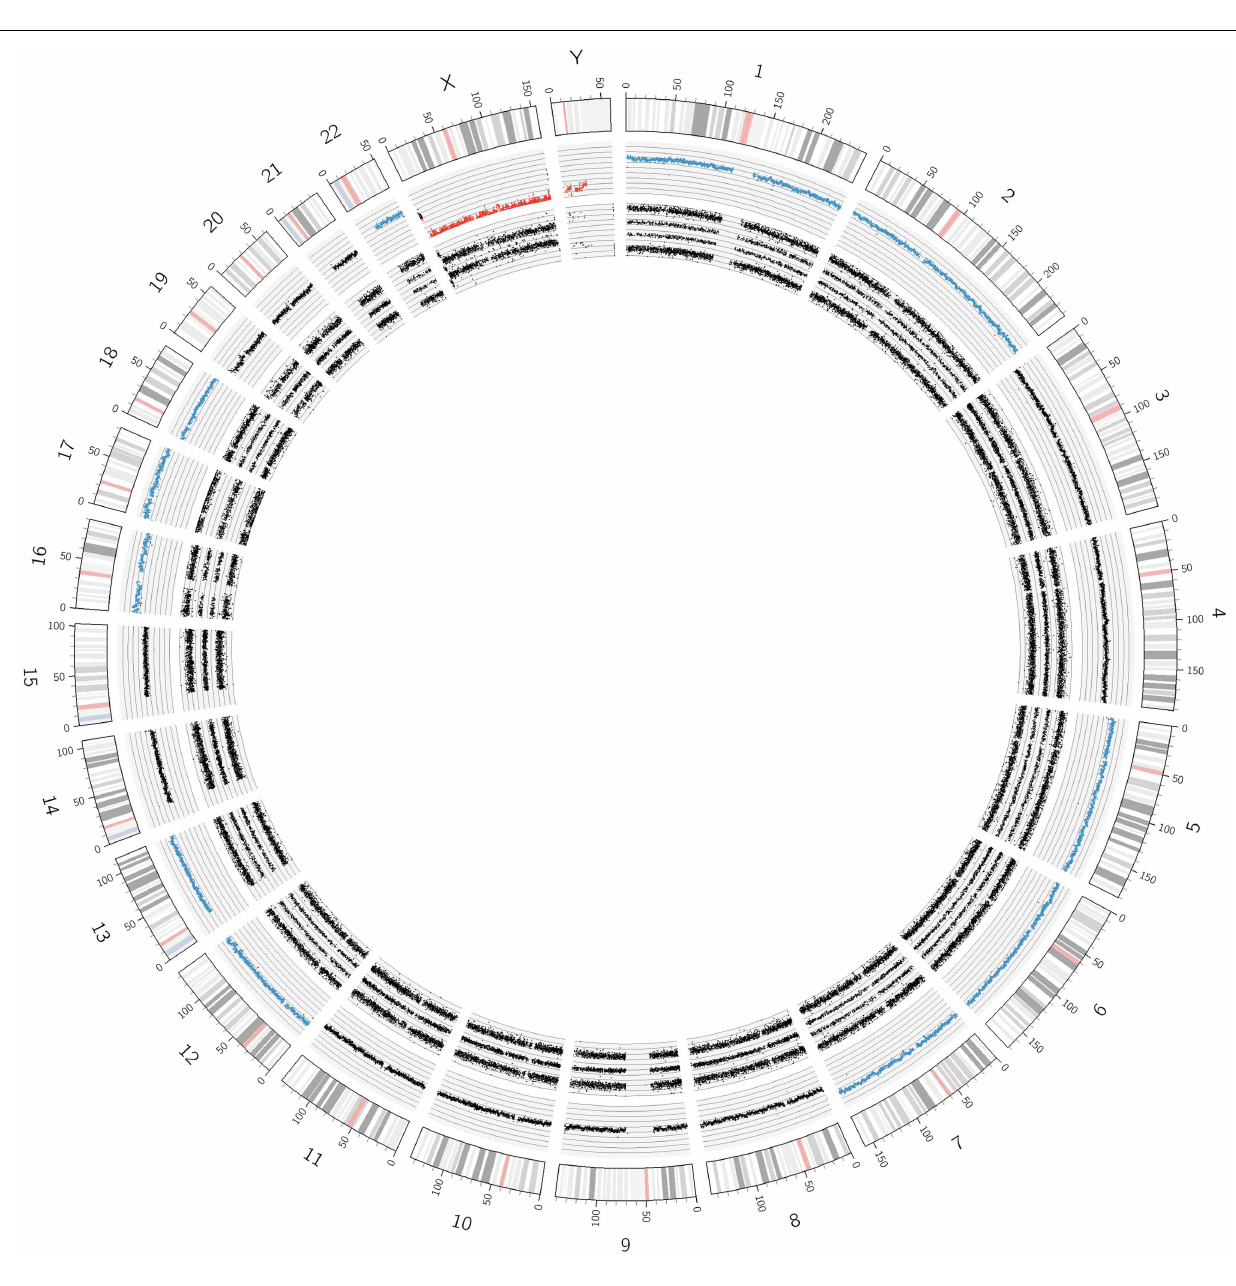
FIGURE 2 | Circos plot of a near-triploid neuroblastoma . Chromosomes 1, 2, 5, 6, 7, 12, 13, 16, 18, and 22 are trisomic, represented by the blue dots in the copy number track and four tracks each for the allele peaks. Note that